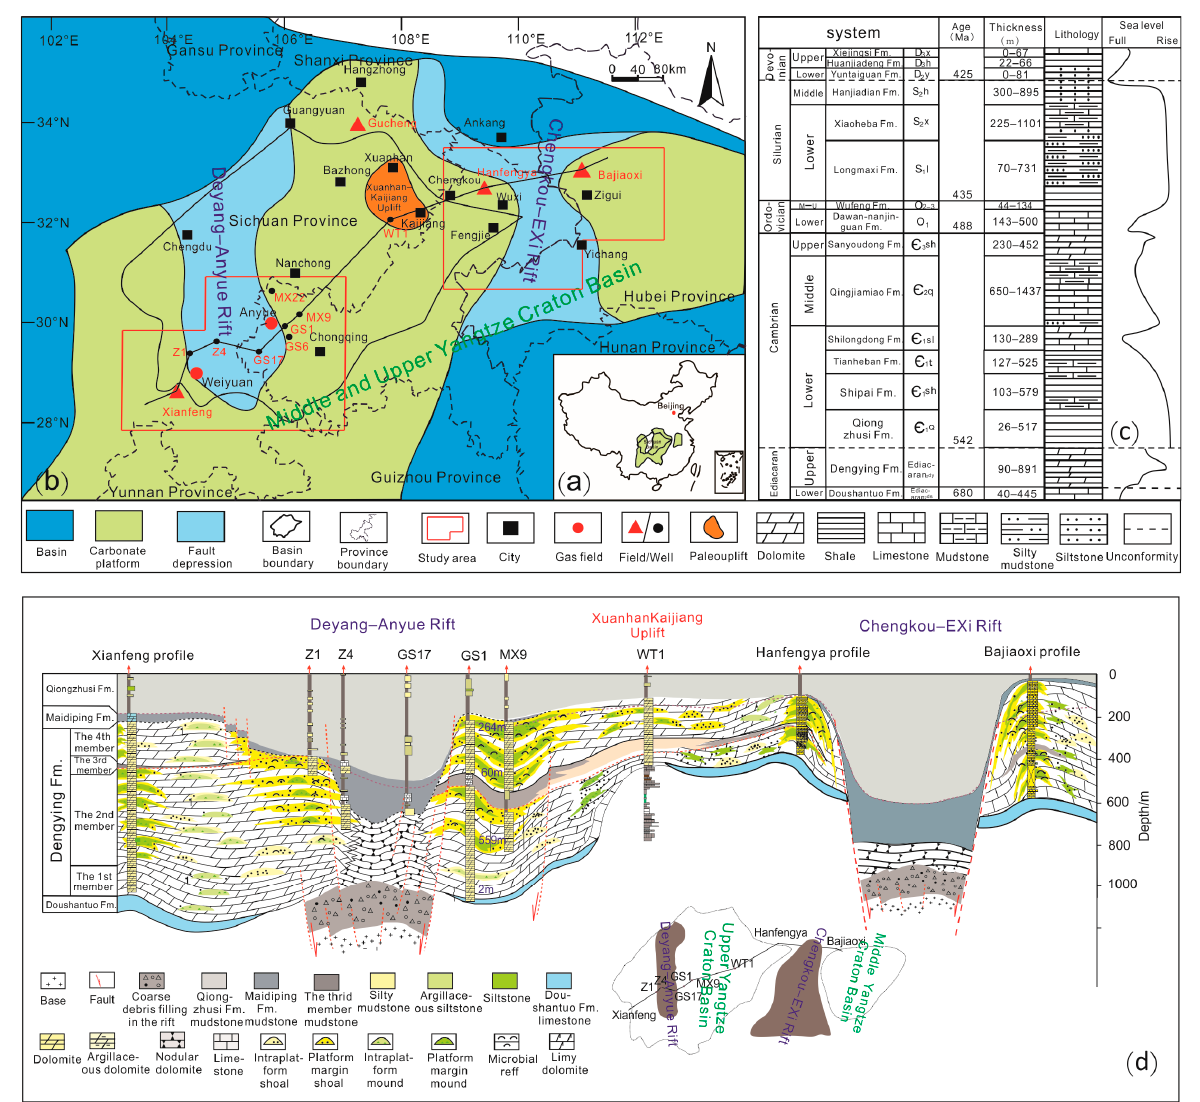
Figure 1. Geological Setting. ( a ) Location of the Sichuan Basin in Southwestern China; ( b ) paleogeo- graphic framework of the Late Ediacaran Eastern Sichuan (modified from [38]); ( c ) the stratigraphic column of the Ediacaran-Devonian in Eastern Sichuan (modified from [39]); ( d ) stratigraphic cross sec- tion of the Dengying Formation in the Mid-Upper Yangtze Craton, flattened by the top of Qiongzhusi Formation (modified from